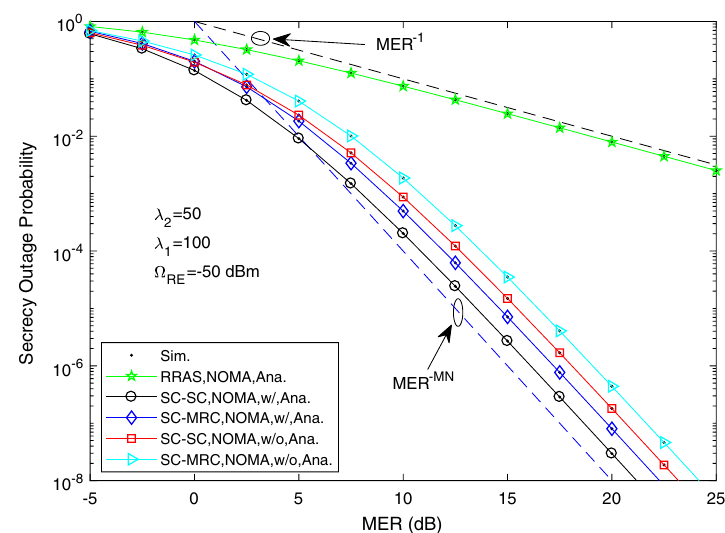
Fig. 8 SOP versus secrecy diversity order. When the transmission power is constant, the impact of the MER is on the